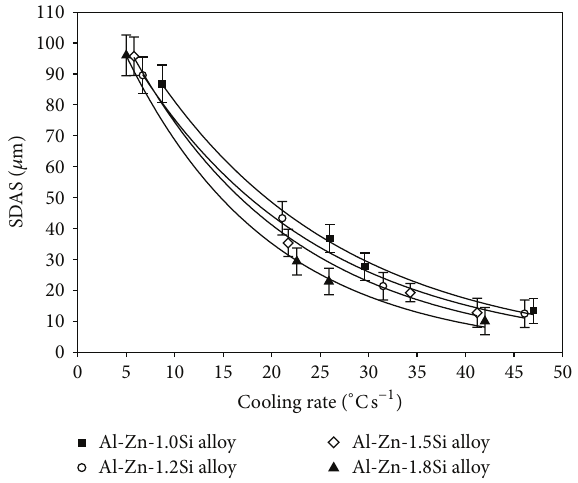
Figure 7: Effect of silicon content on the solidification range in Al- Zn